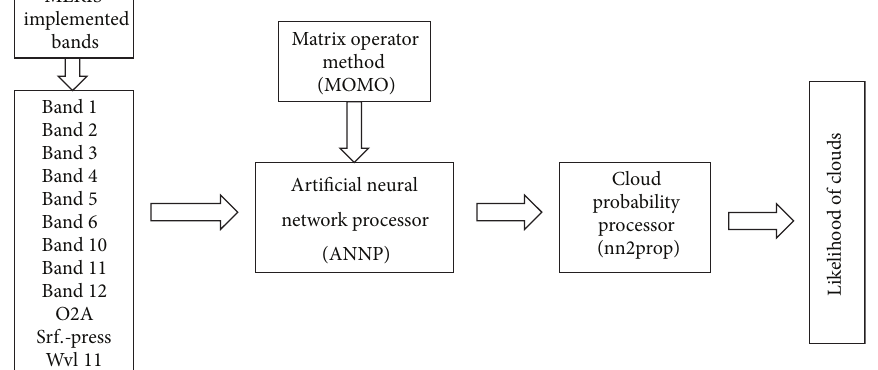
Figure 2: Cloud detection algorithm.